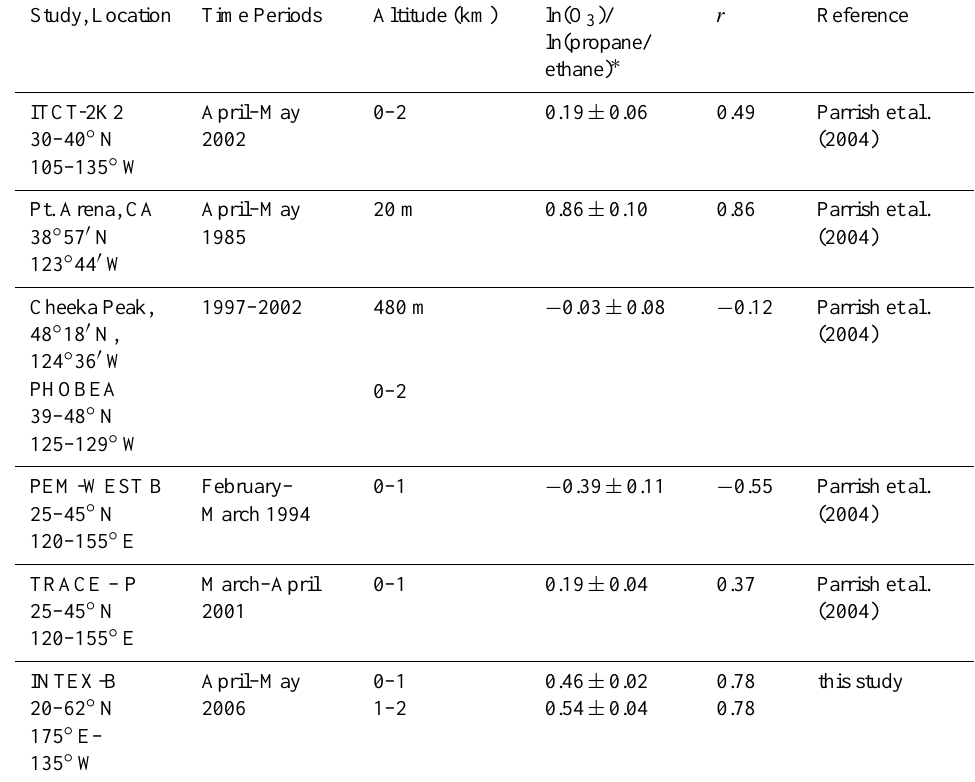
Table 2. Qualitative determinations of integrated net ozone production rates as determined from correlations between ozone and the ratio of propane to ethane.